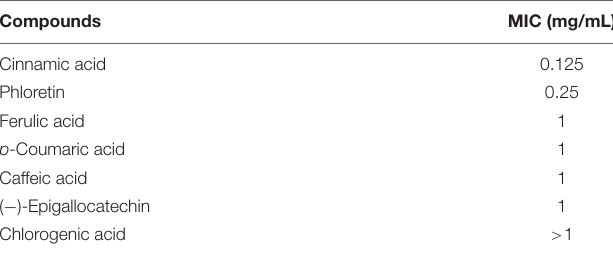
TABLE 2 | Minimum inhibitory concentrations (MICs) of seven phenolic compounds against S. maltophilia 4–1. Compounds MIC (mg/mL) Cinnamic acid